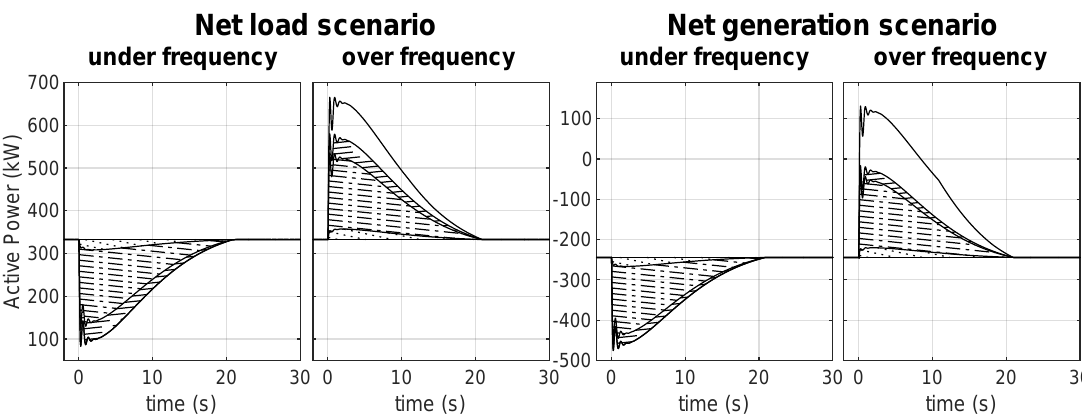
Figure 23. Active power-frequency support provided by the ST to the main power system, obtained from non-controllable loads (dotted area), controllable energy storage (dot-dash area), controllable EV charging (dashed area) and controllable PV generation (white area). Positive values represent power